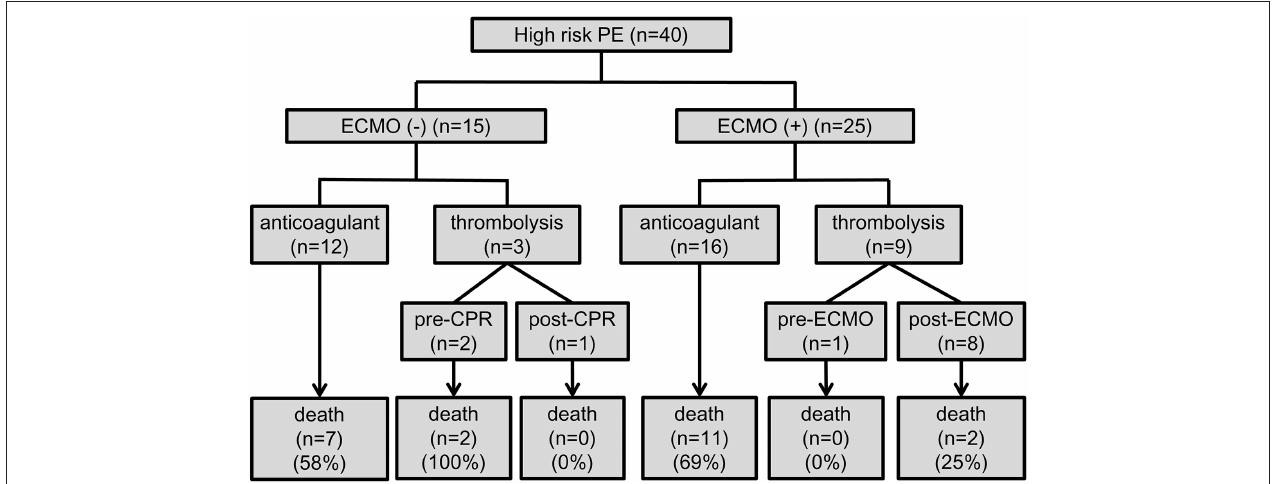
FIGURE 2 | Flow chart of the treatment strategies and outcomes. CPR, cardiopulmonary resuscitation; ECMO, veno-arterial extracorporeal membrane oxygenation; PE, pulmonary embolism. four patients, and catheter-directed thrombolysis was performed in eight patients (see Supplementary Table 2 ). None of the patients underwent a surgical embolectomy. There was no difference in the management strategy between the ECMO and non-ECMO groups.